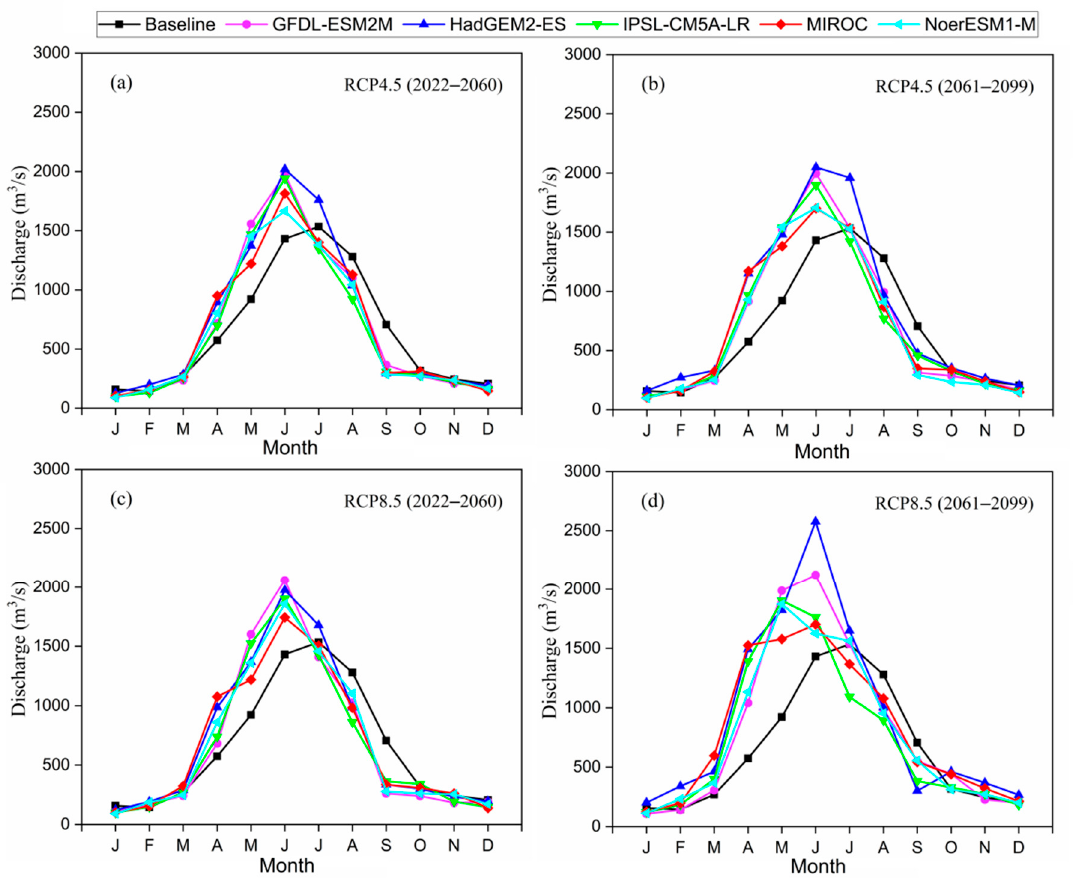
Figure 12. Monthly simulated discharge during the 2022–2060 and 2061–2099 time periods for the five GCMs under ( a,b ) RCP4.5 and ( c,d ) RCP8.5 in the Vakhsh River Basin, Central Asia.